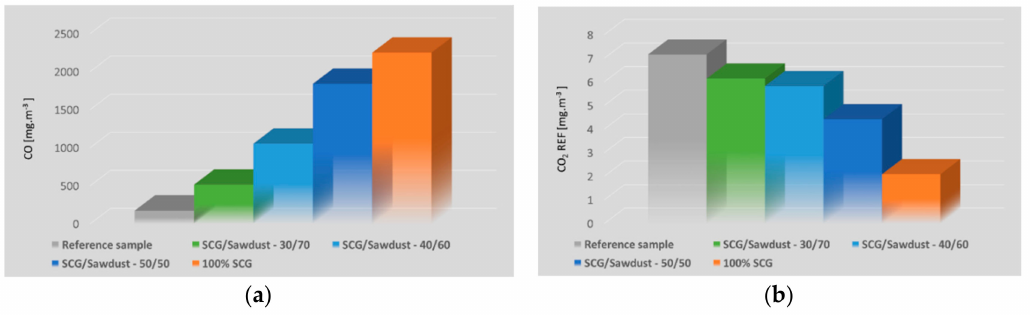
Figure 5. ( a ) Comparison of average CO emissions and ( b ) comparison of average CO 2